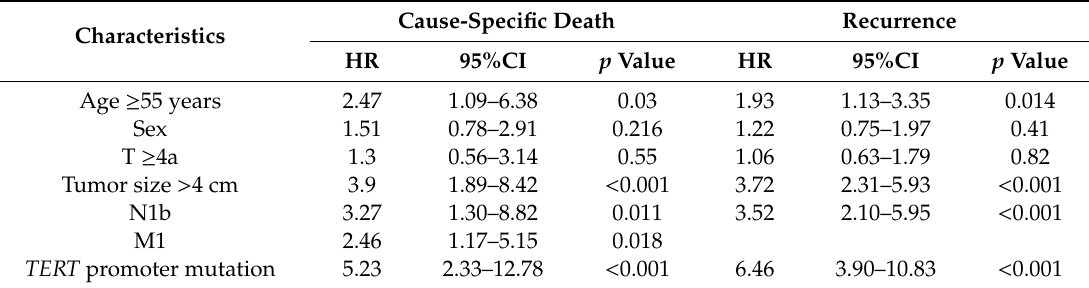
Table 5. Cox proportional hazard regression analysis of variables associated with